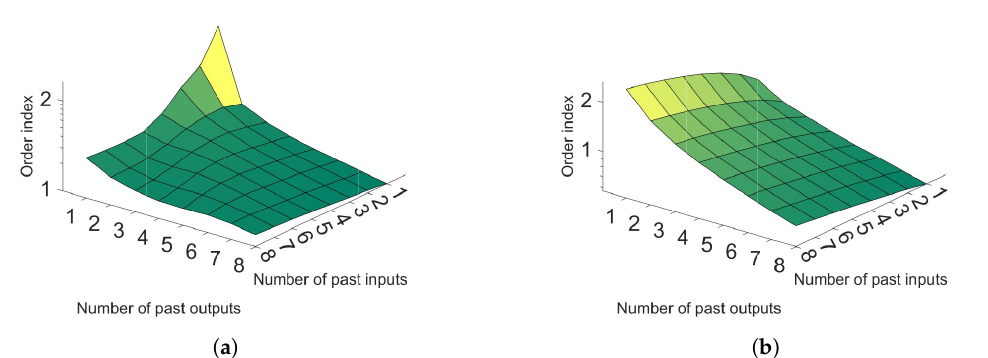
Figure 9. ( a ) Lipschitz surface for reactor temperature; ( b ) Lipschitz surface for polymer